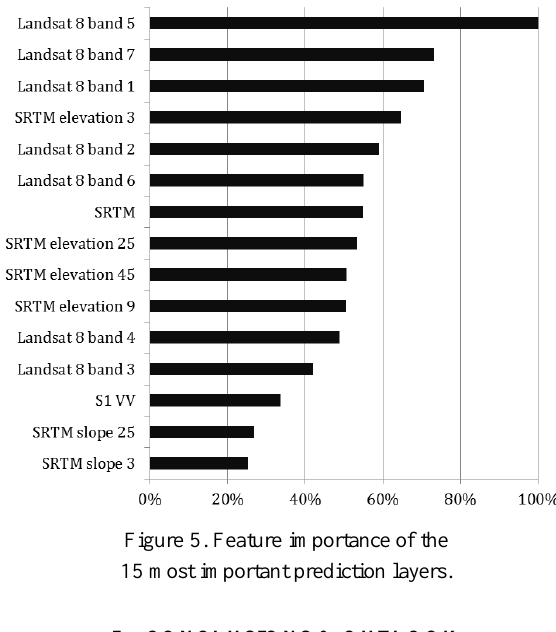
Figure 5. Feature importance of the 15 most important prediction